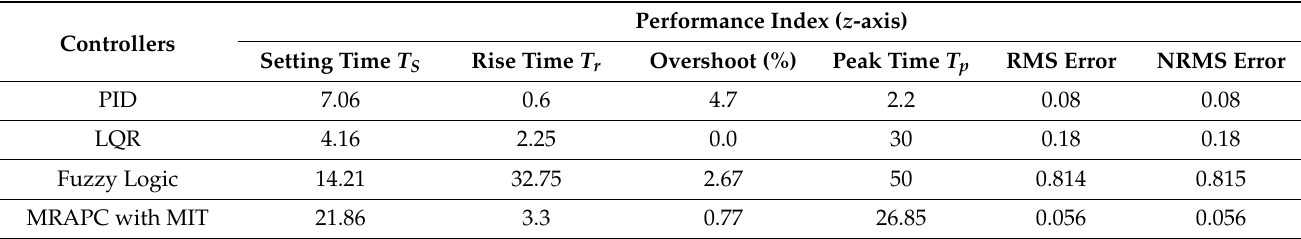
Table 8. Performance comparison of control techniques for